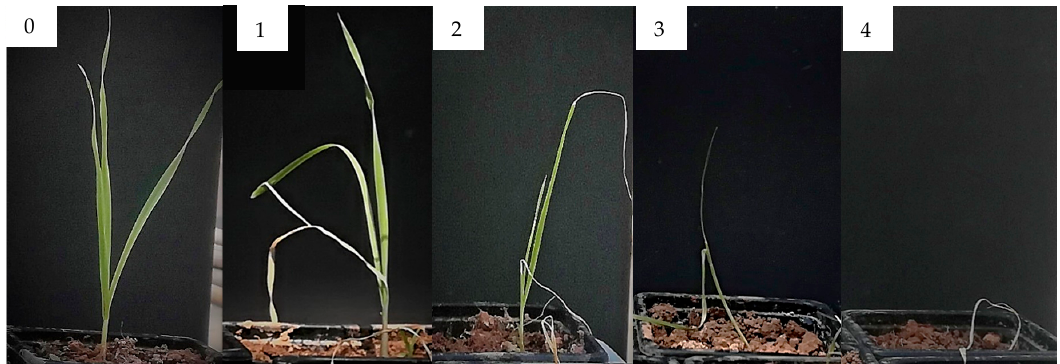
Figure 13. Damage level scale of Avena fatua. 0 Undamaged plant, 1 Plant with slight damage, 2 Plant with severe damage, 3 Critically damaged plant, 4 Dead plant.